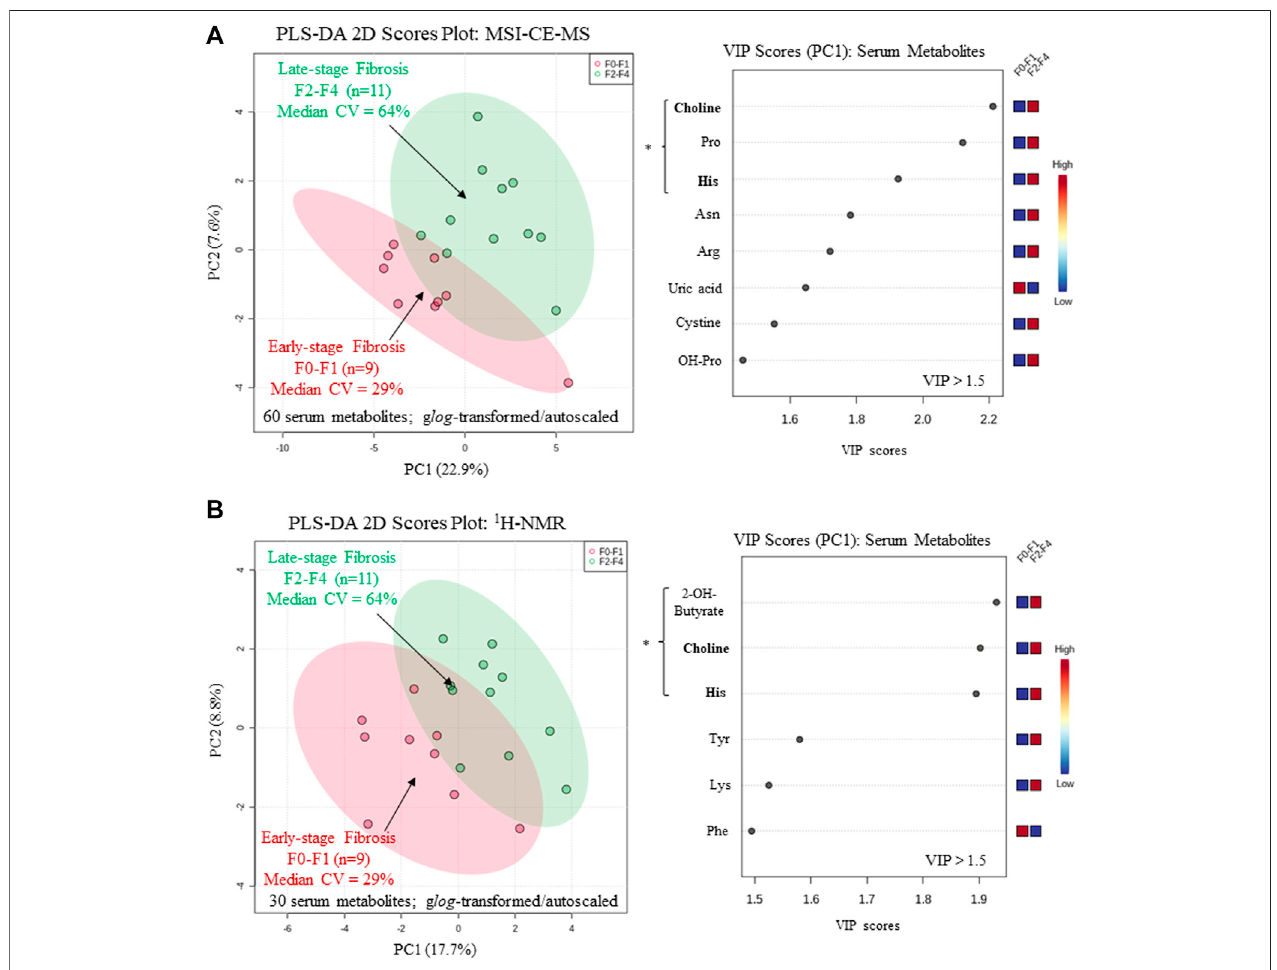
FIGURE 4 | Supervised multivariate data analysis of serum metabolome characterized by (A) MSI-CE-MS and (B) 1H-NMR when using a partial least-squares- discriminateanalysis(PLS-DA)modelfordifferentiationofchronicHCVpatientswithearly(F0-F1)fromlate-stage(F2-F4)liver fi brosisasdeterminedbyhistopathology.A variable importance in projection (VIP) scores (VIP > 1.5) were used to rank order important serum metabolites associated with liver fi brosis progression highlighting consistentoutcomesforcholineandhistidine(bolded)inbothplatforms.Allserummetabolitesweregeneralized log -transformedandautoscaled,where*indicates statistically signi fi cant serum metabolites between HCV sub-groups ( p <